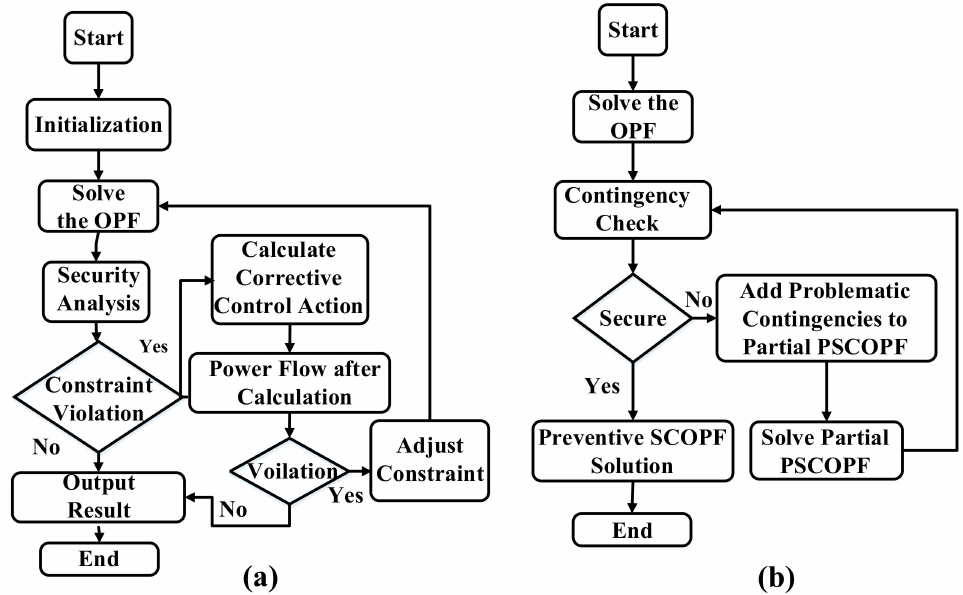
Figure 5. The SCOPF procedures. ( a ) Implementation corrective SCOPF procedure and ( b ) imple- mentation of preventive SCOPF